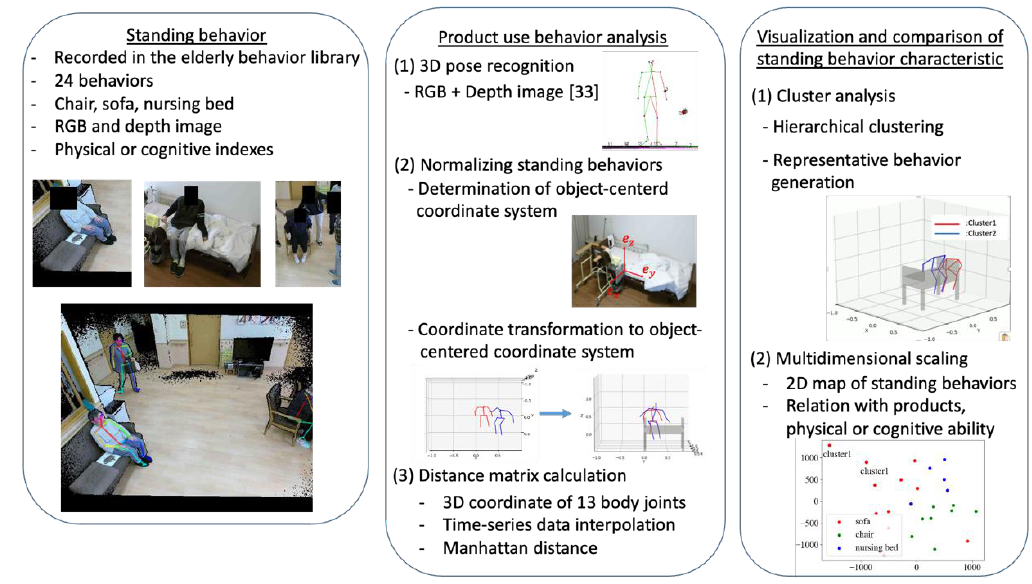
Figure 3. Outline of proposed method.